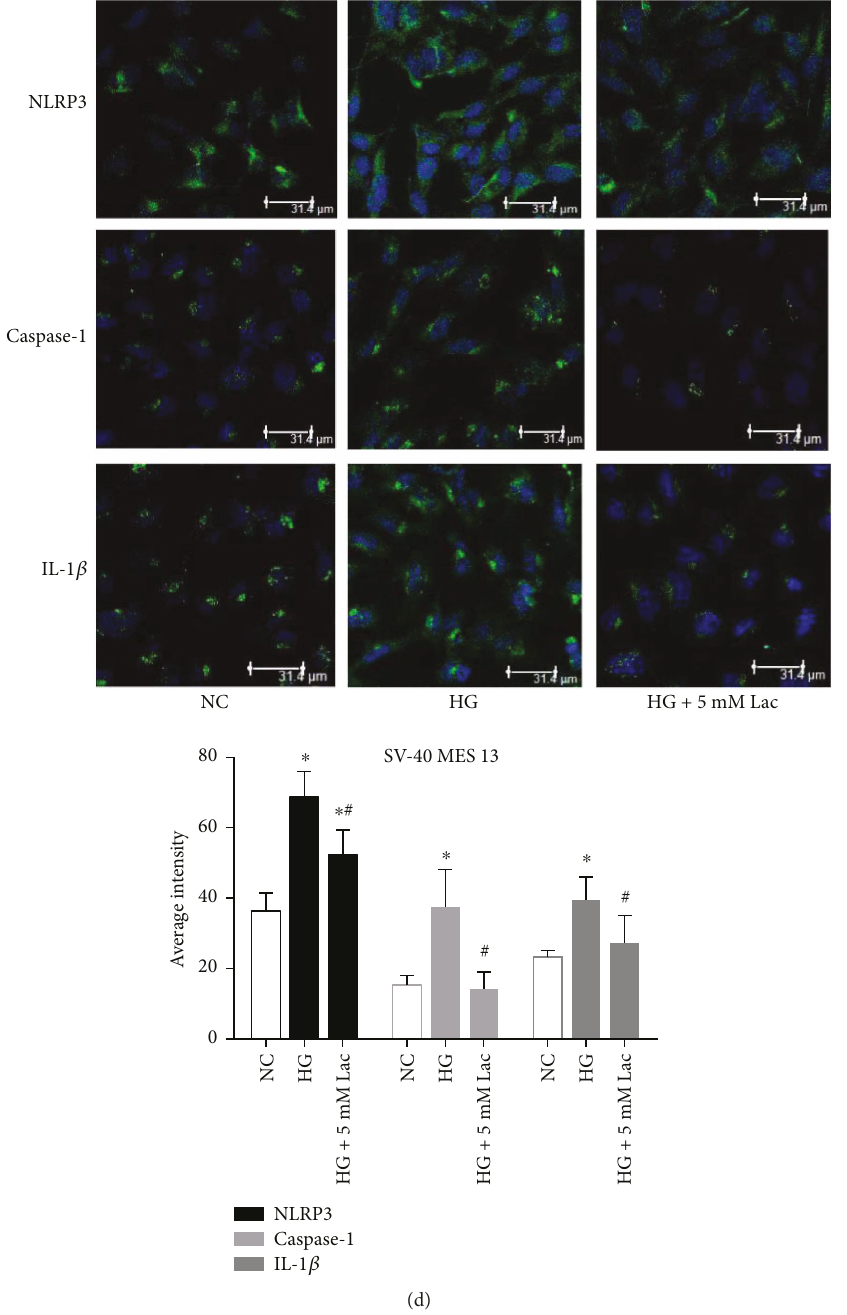
Figure 5: High glucose-induced activation of ROS-NLRP3 in fl ammasome signaling was reversed by lactisole. (a) The fl uorescence images (100 × ) and quantitative assay for intracellular ROS was determined by detection kits. (b) The protein and mRNA expression of NLRP3, cleaved caspase-1, and cleaved IL-1 β were detected by Western blotting. (c) IL-1 β protein level in the cell culture supernatant was assayed after lactisole treatment. (d) Immuno fl uorescence and a laser scanning confocal microscope (400 × ) detected the expressions of NLRP3, caspase-1, and IL-1 β in GMCs as green fl uorescence that overlapped with blue fl uorescence emitted by the nuclear stain DAPI. The values of semiquantitative analysis for average intensity were assessed and the gray graphs con fi rmed these trends. Data are expressed as mean ± SD. ∗ p < 0 05 versus NC group. # p < 0 05 versus 30 mmol/L glucose (HG) stimulation